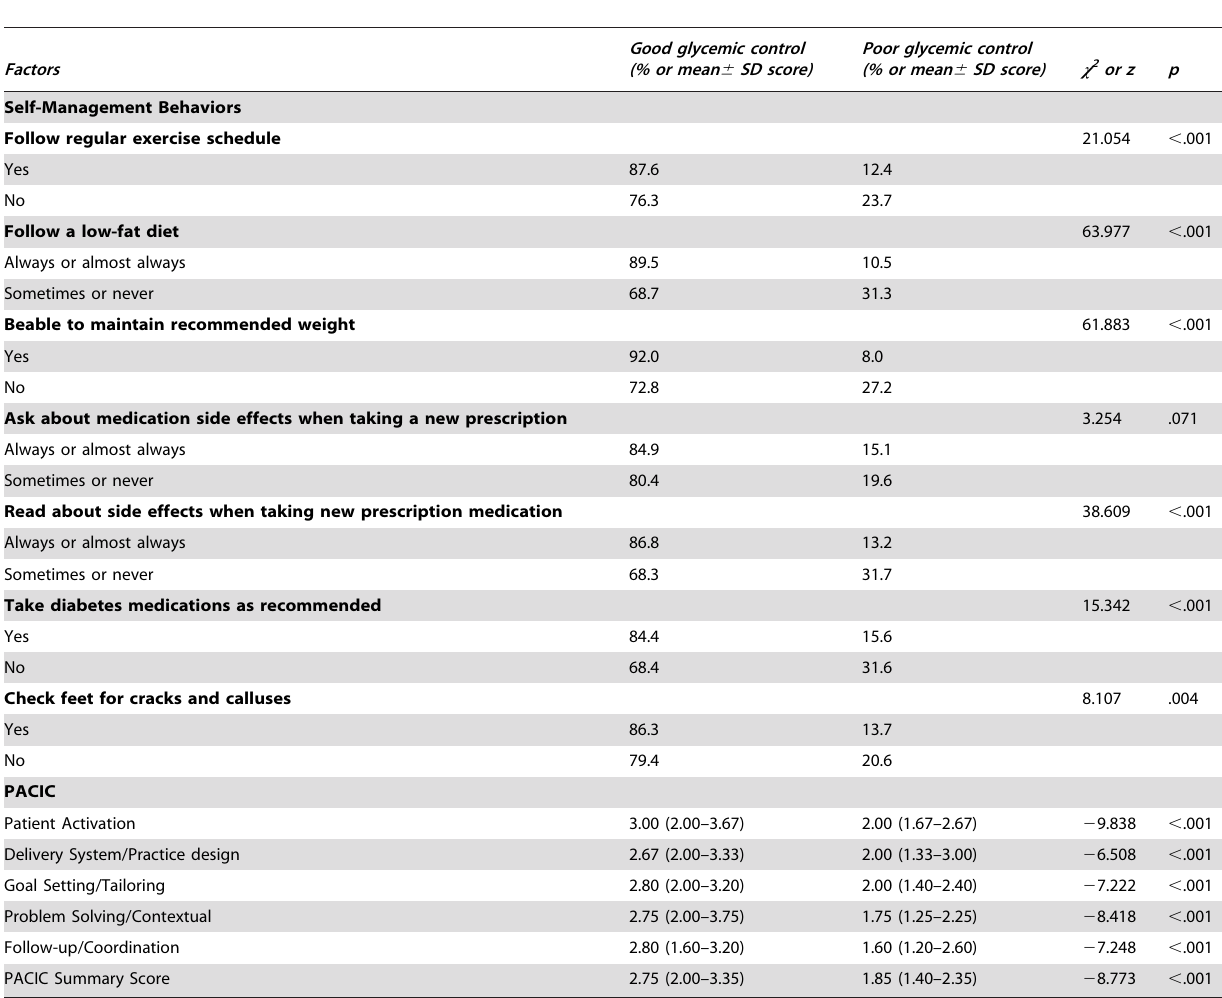
Table 3. The relationships between different self-management behaviors and glycemic control, and the relationships between PACIC and glycemic control (N =960).